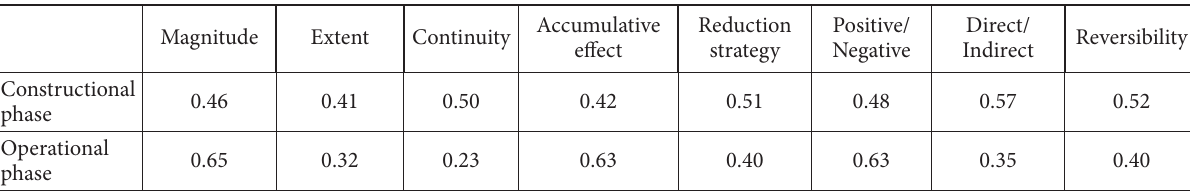
Table 4. Control of values coordination in two